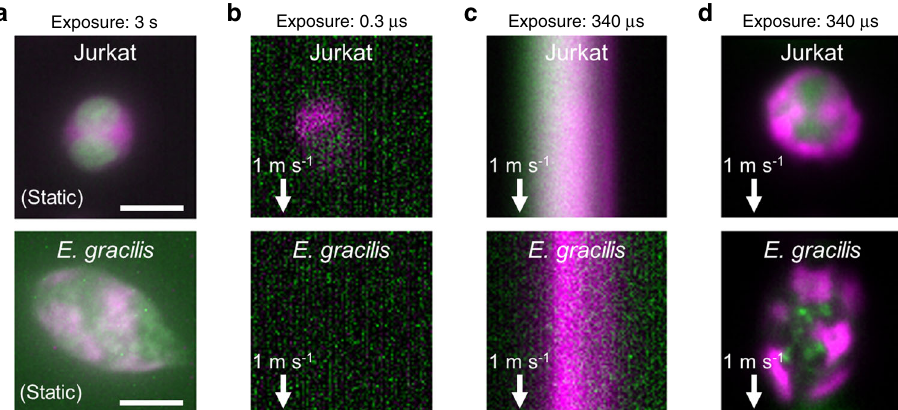
Fig. 2 Demonstration of VIFFI fl ow cytometry. Immortalized human T lymphocyte cells (Jurkat) and E. gracilis cells are used for all cases. a Fluorescence images of the cells at rest obtained by conventional fl uorescence microscopy. The images are representatives of >10 images of cells obtained under identical imaging conditions. b Fluorescence images of the cells in a 1-m s − 1 fl ow obtained by IFC without VIFFI with an exposure time of 0.3 µ s. c Fluorescence images of the cells in a 1-m s − 1 fl ow obtained by IFC without VIFFI with an exposure time of 340 µ s. d Fluorescence images of the cells in a 1-m s − 1 fl ow obtained by IFC with VIFFI with an exposure time of 340 µ s. Green: nucleus for Jurkat cells (stained by SYTO16), lipids for E. gracilis cells (stained by BODIPY505/515). Magenta: cytoplasm for Jurkat cells (stained by CellTracker Red), chlorophyll for E. gracilis cells (auto fl uorescence). It is clear from the comparison of the fl uorescence images that VIFFI signi fi cantly improved the spatial resolution and SNR in the images without sacri fi cing the throughput. Scale bars: 10 µ m.